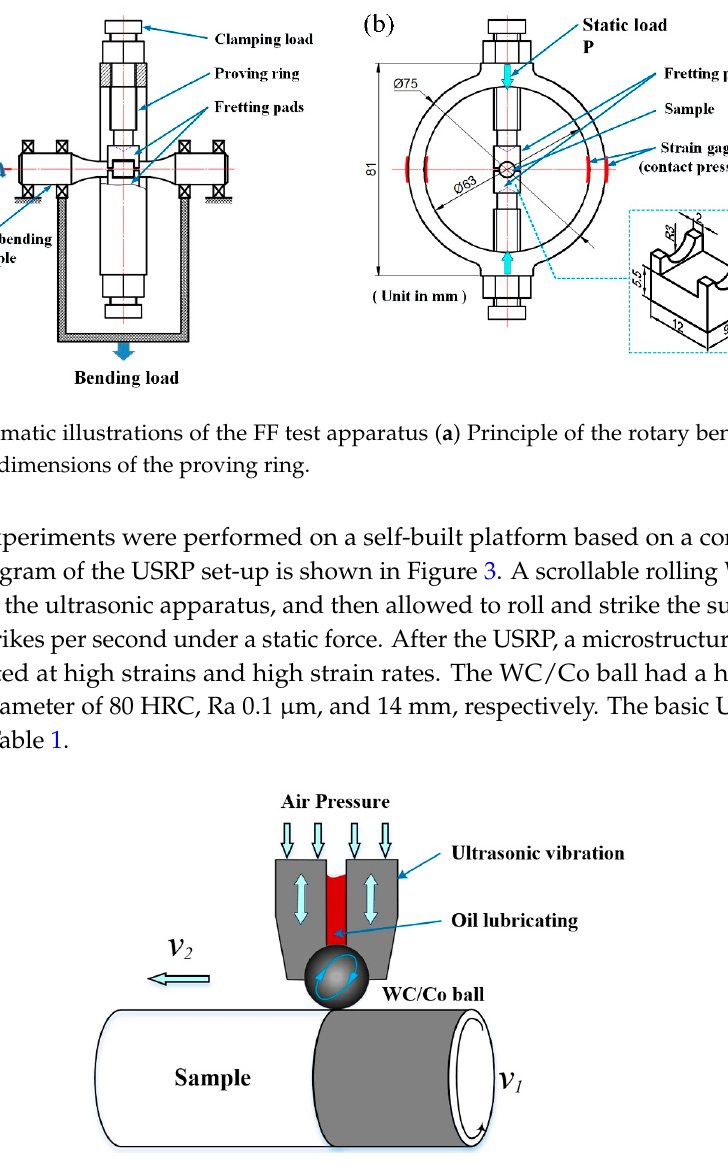
Figure 3. Schematic illustration of USRP set-up. Table 1. The basic USRP parameters.